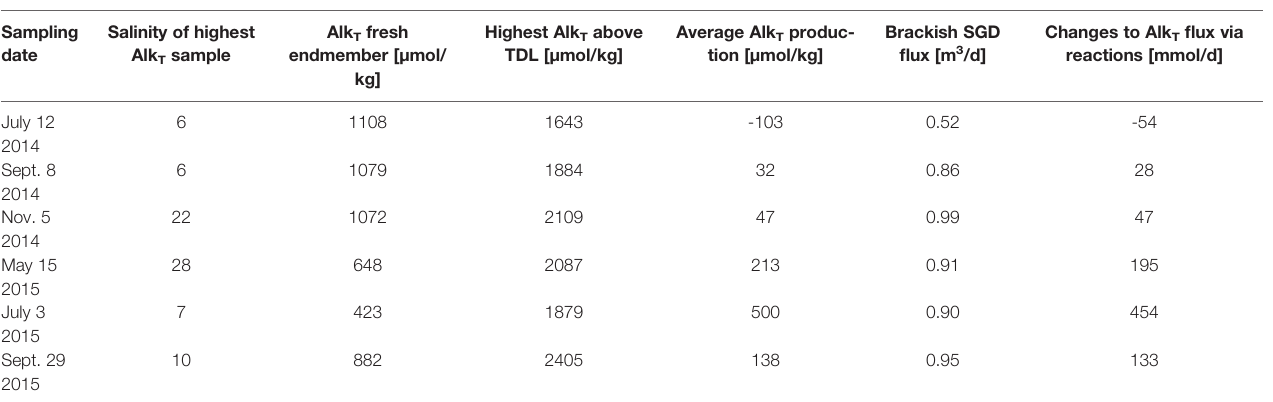
TABLE 2 | Total seasonal Alk T production spanning seasons.